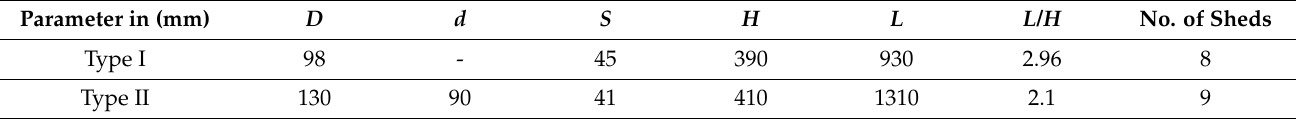
Figure 1. Geometries of type ( I ) and type ( II ) insulators, where insulator type ( I ) has a constant shed diameter D while insulator type ( II ) has alternating big and small sheds with diameters D and d , respectively. Table 1. Dimensions of type I and type II insulators.